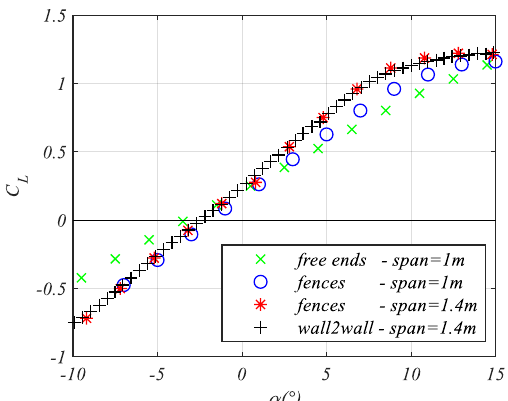
Figure 3. Lift coefficient versus angle of attack for various wing configurations. Re = 0.75 × 10 6. The wing was instrumented with 31 piezoresistive pressure transducers (Kulite XCS- 062 and Meggitt 8515C-15) (Figure 4a) at the wing midspan, the output of which was am- plified by custom made amplifiers, installed in the interior of the wing (Figure 4b). All transducers were calibrated in the interval ±2 kPa and their sensitivity was close to 1mV/Pa. The locations of the transducers are shown in Figure 4c, being at small distances between each other in the suction side of the leading edge region where the pressure gradient takes high values.